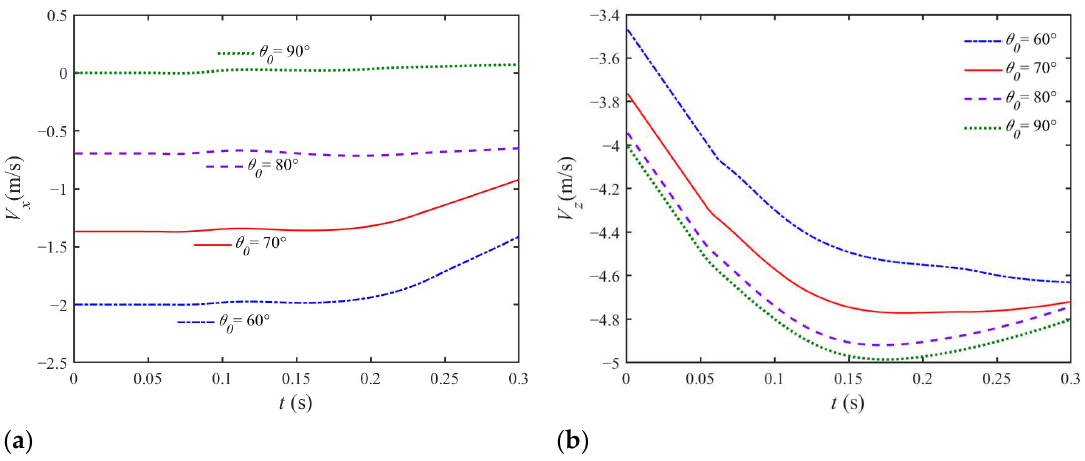
Figure 21. Comparison of time history curve of ( a ) horizontal velocity and ( b ) vertical velocity for the water entry of UAUV with different initial pitch angles.